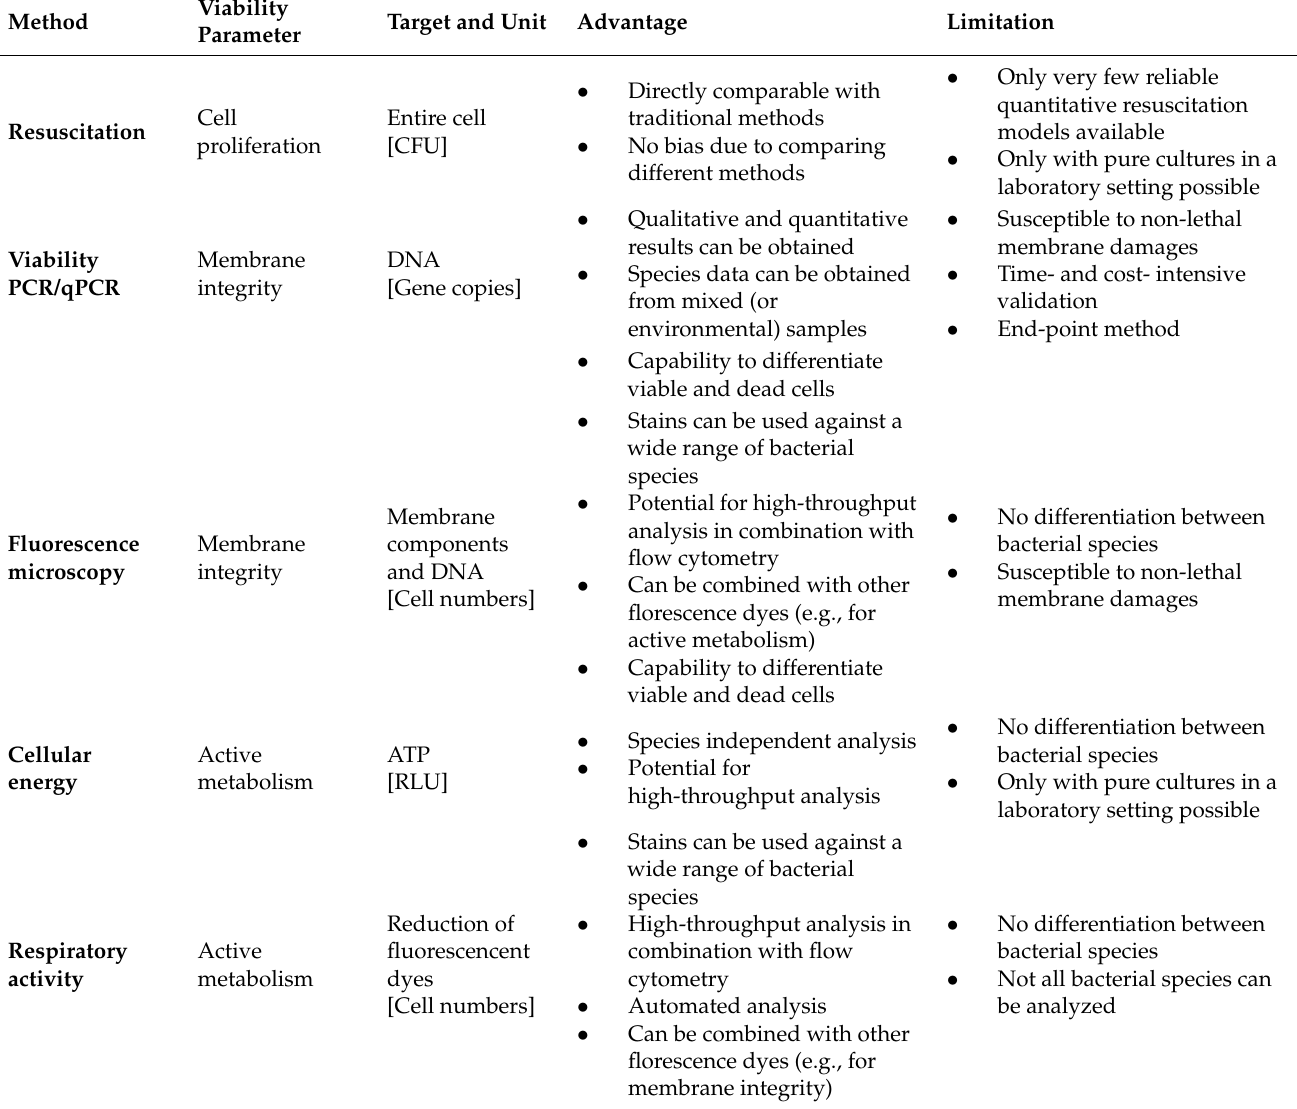
Table 2. Summary of the currently available methods for resistance screening for